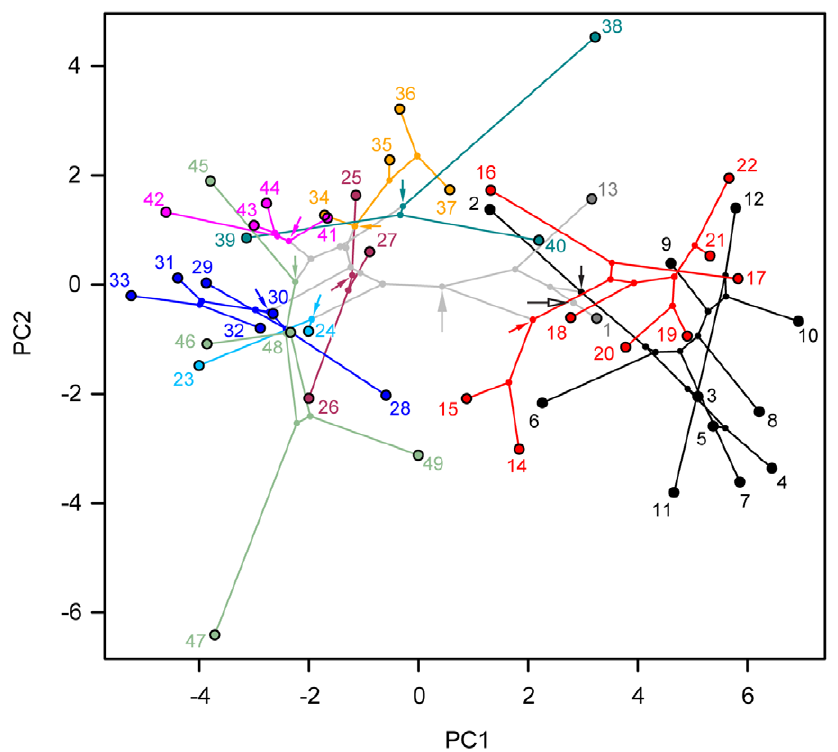
Figure 5. Two-dimensional phylomorphospace plot. The felid phylogeny (Fig. 2) was superimposed onto the two-dimensional morphospace delimited by the first two PC axes (Fig. 4A) using maximum likelihood ancestor character estimation. Arrows indicate ancestral nodes for clades of interest and color-coded as in Fig. 2 but also: open, Felidae; and grey, Felinae. Numbers and colors are as in Fig. 2.